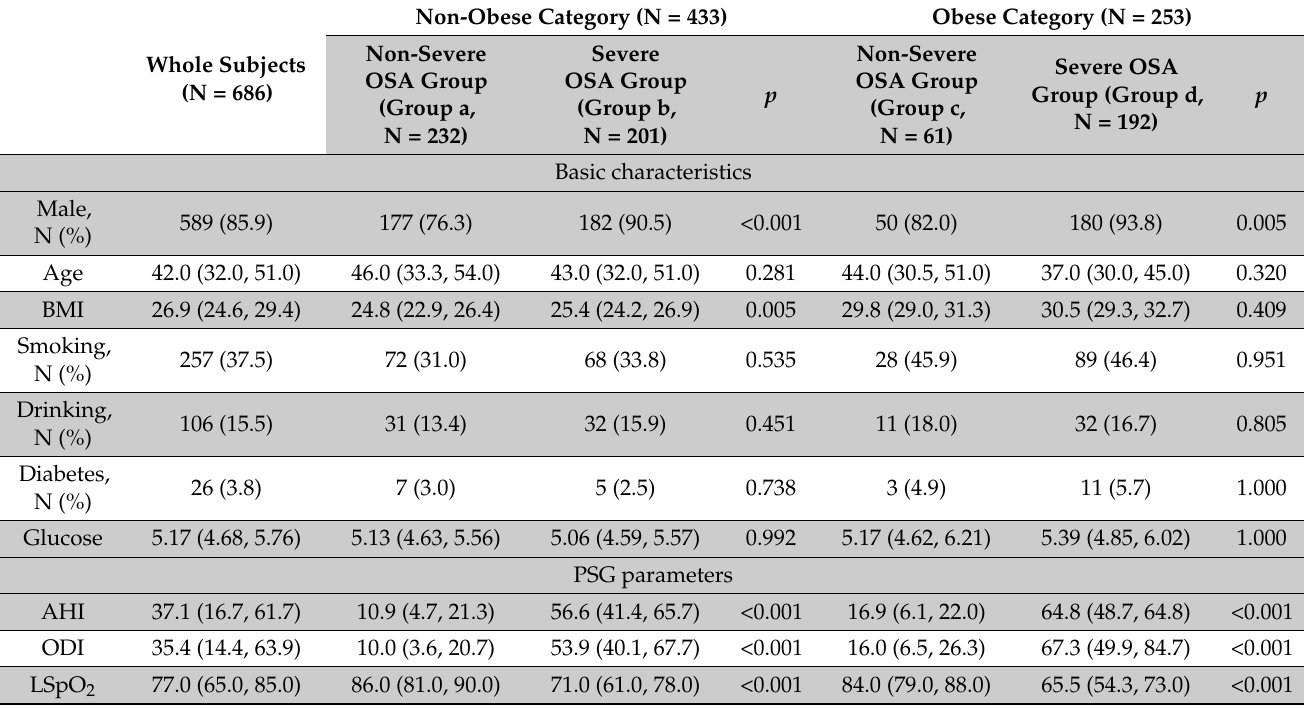
Table 1. Basic characteristics and PSG parameters stratified by obesity and severe OSA.